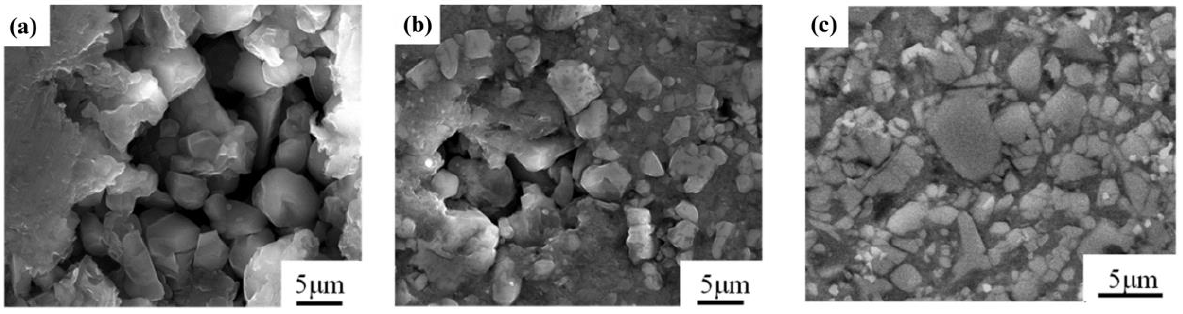
Figure 6. SEM figure of the 45 vol.% AlN/Al composites with different holding times: ( a ) 10 min; ( b ) 20 min; and ( c ) 30 min.